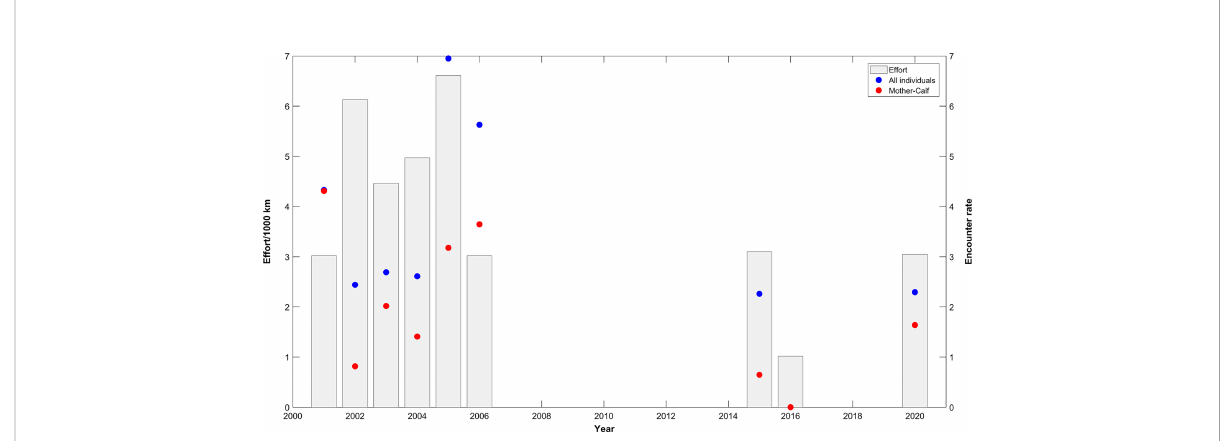
FIGURE 2 Encounter rates of humpback whales in the Osa Peninsula, Costa Rica. Effort made in each breeding season (gray bars); Encounter rate including adults and mother-calf pairs (blue dots); and Encounter rate of mother-calf pairs (red dots).